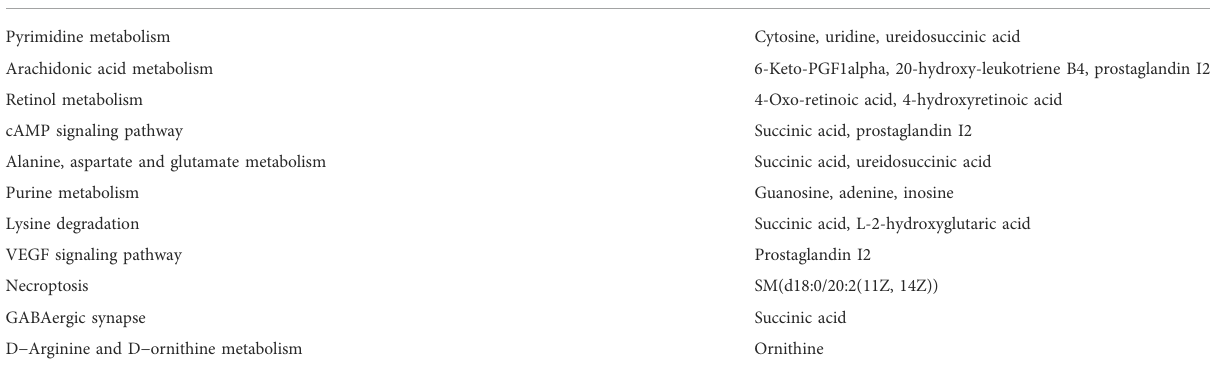
TABLE 1 The key metabolites related to the pathways. Pathway name